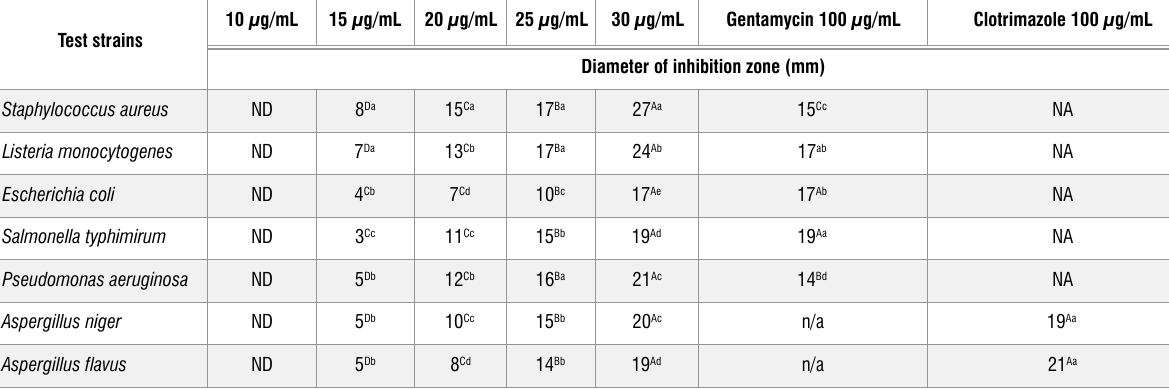
Antimicrobial activity of crude fucoxanthin from Dilophys fasciola 10 Test strains